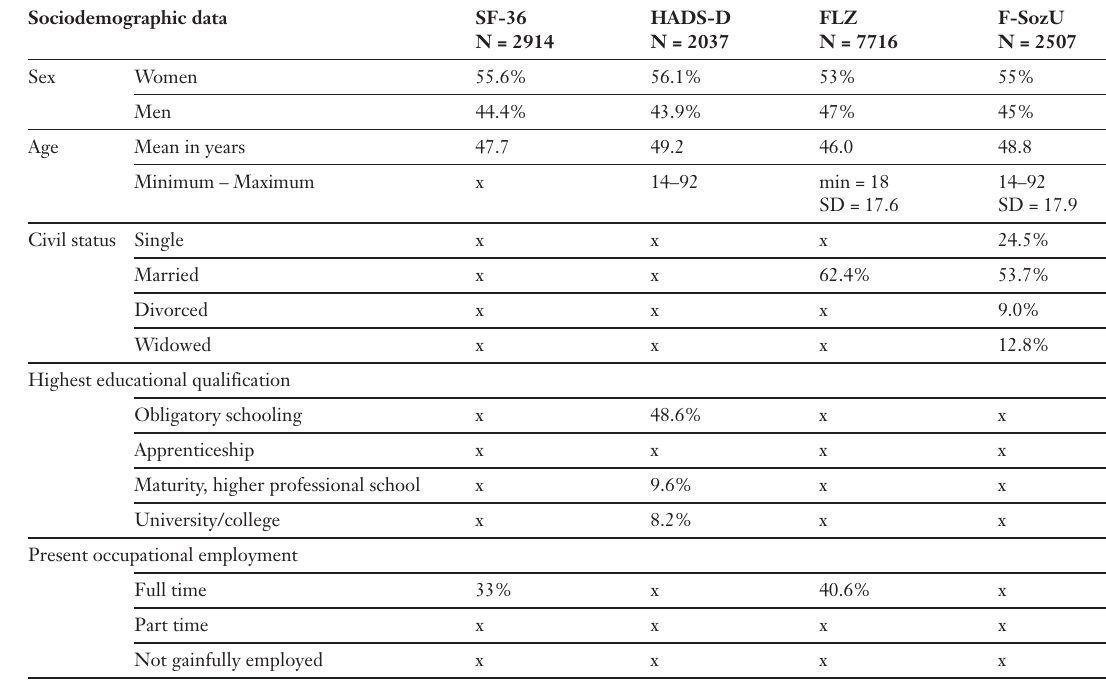
Sociodemographic data of the commu- nity normal samples regarding the psy- chometric question- naires that are ad- ministered in this study [45, 46, 49, 50].